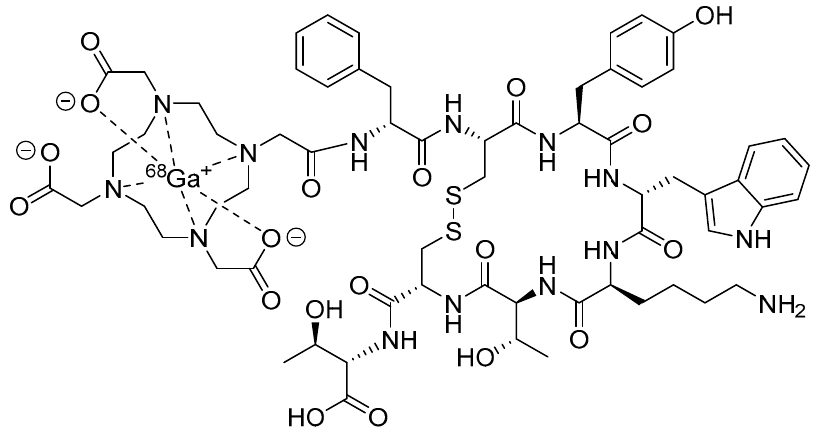
Figure 2. Structure of [ 68 Ga]DOTATATE (NETSPOT ® ).